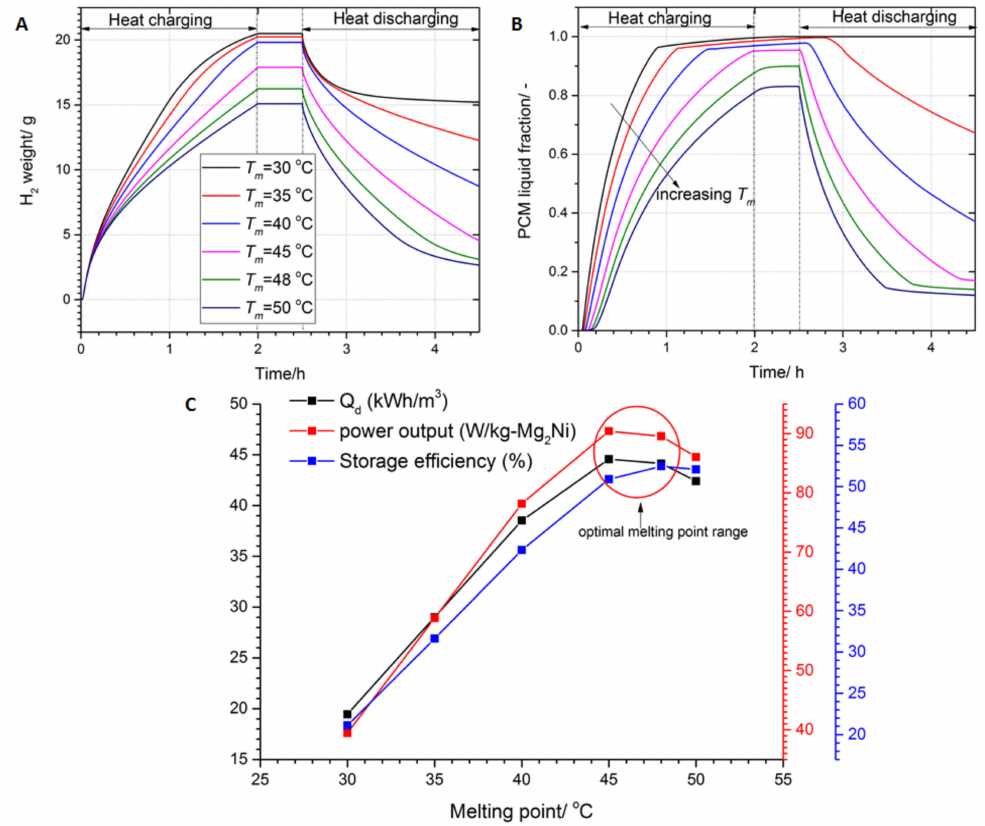
Figure 3. The e ff ect of melting point on ( A ) the H 2 weight absorbed / desorbed by the Low-Temperature Metal hydride bed. ( B ) The phase change material (PCM) liquid fraction in the jacket. ( C ) performance indexes of the heat storage